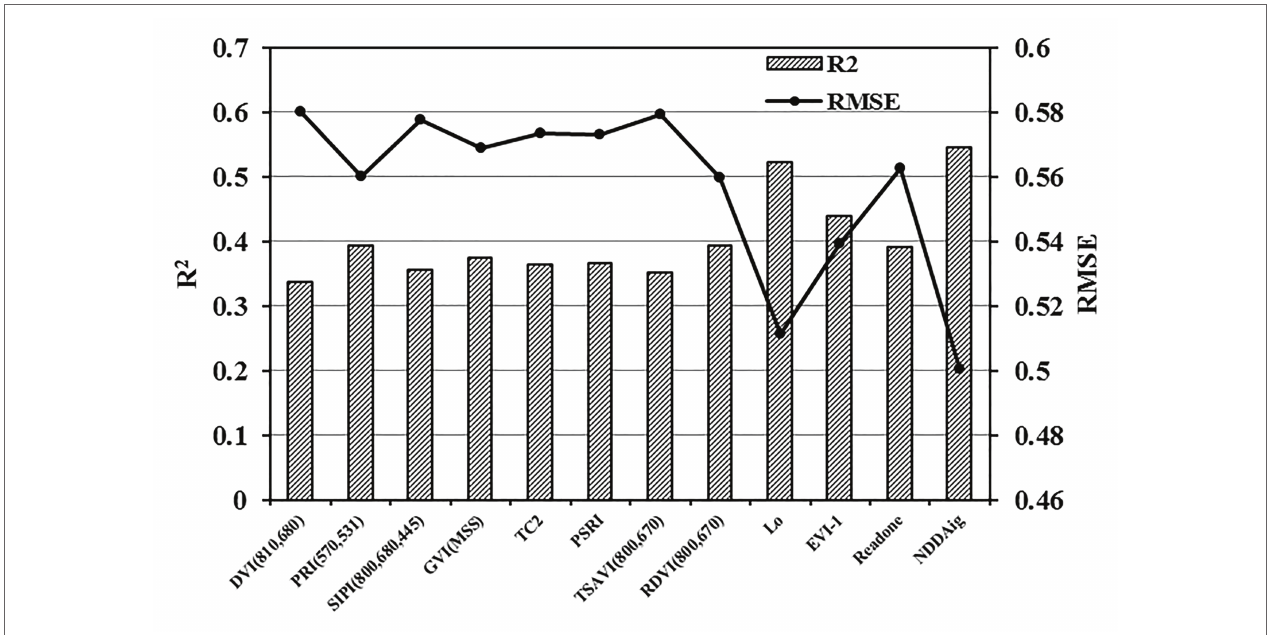
FIGURE 3 | Relationships between common vegetation indices and WUE ( n = 140).